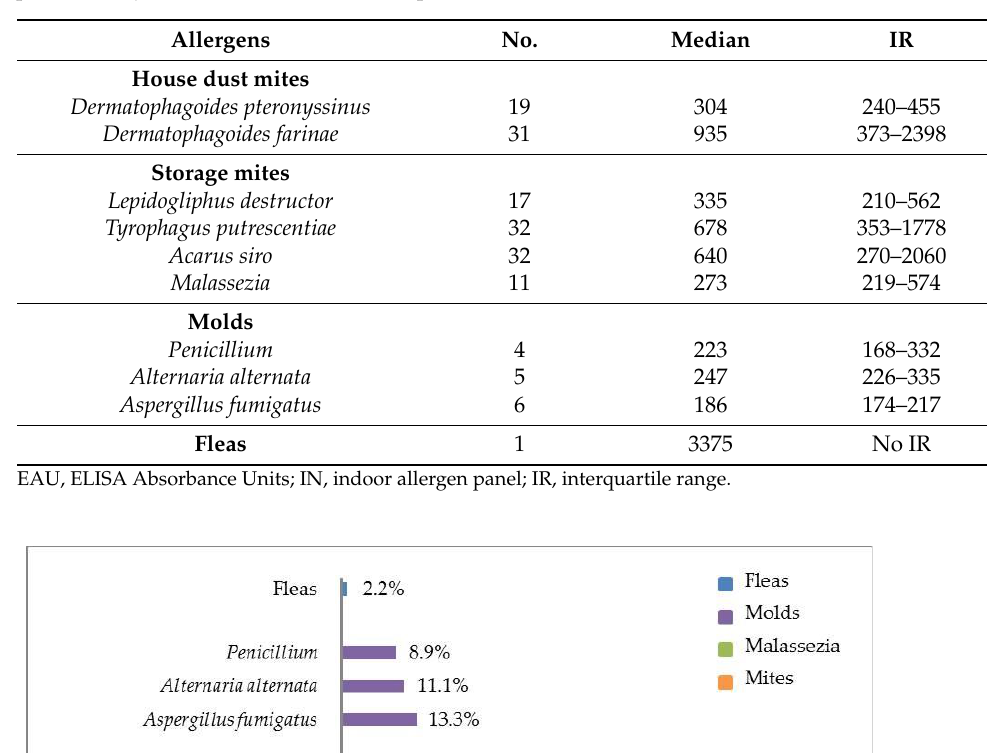
Table 2. Serum IgE concentrations (ELISA Absorbance Units (EAU)) of various allergens in IN positive subjects ( n = 45) with canine atopic dermatitis.